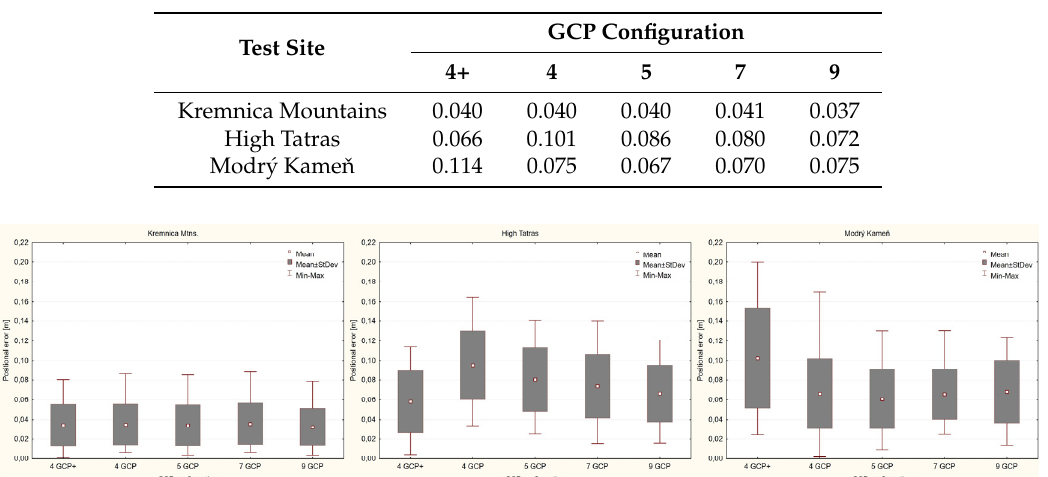
Table 3. Root mean square horizontal errors RMSE xy according to the test sites and GCP configurations (in metres).